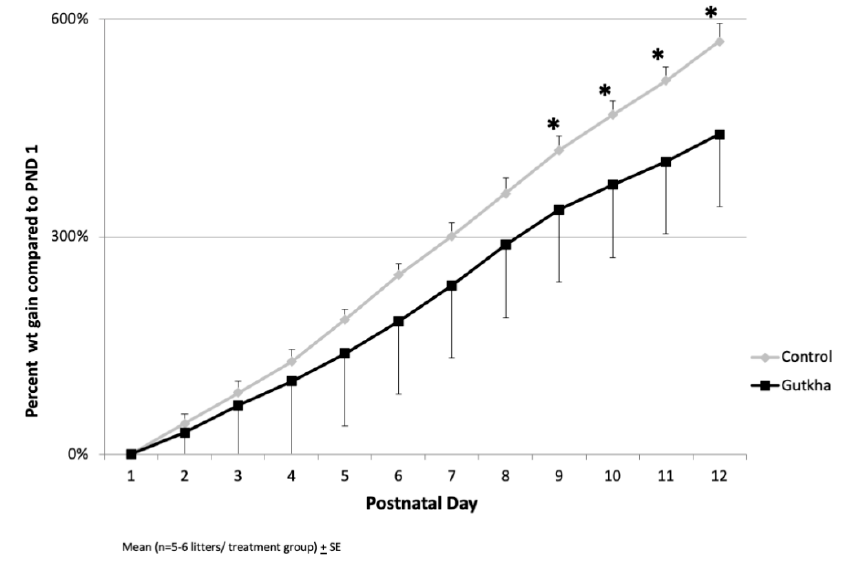
Figure 2. Prenatal exposure to gutkha significantly reduced o ff spring weight gain (* p < 0.05) over time up to PND 12.